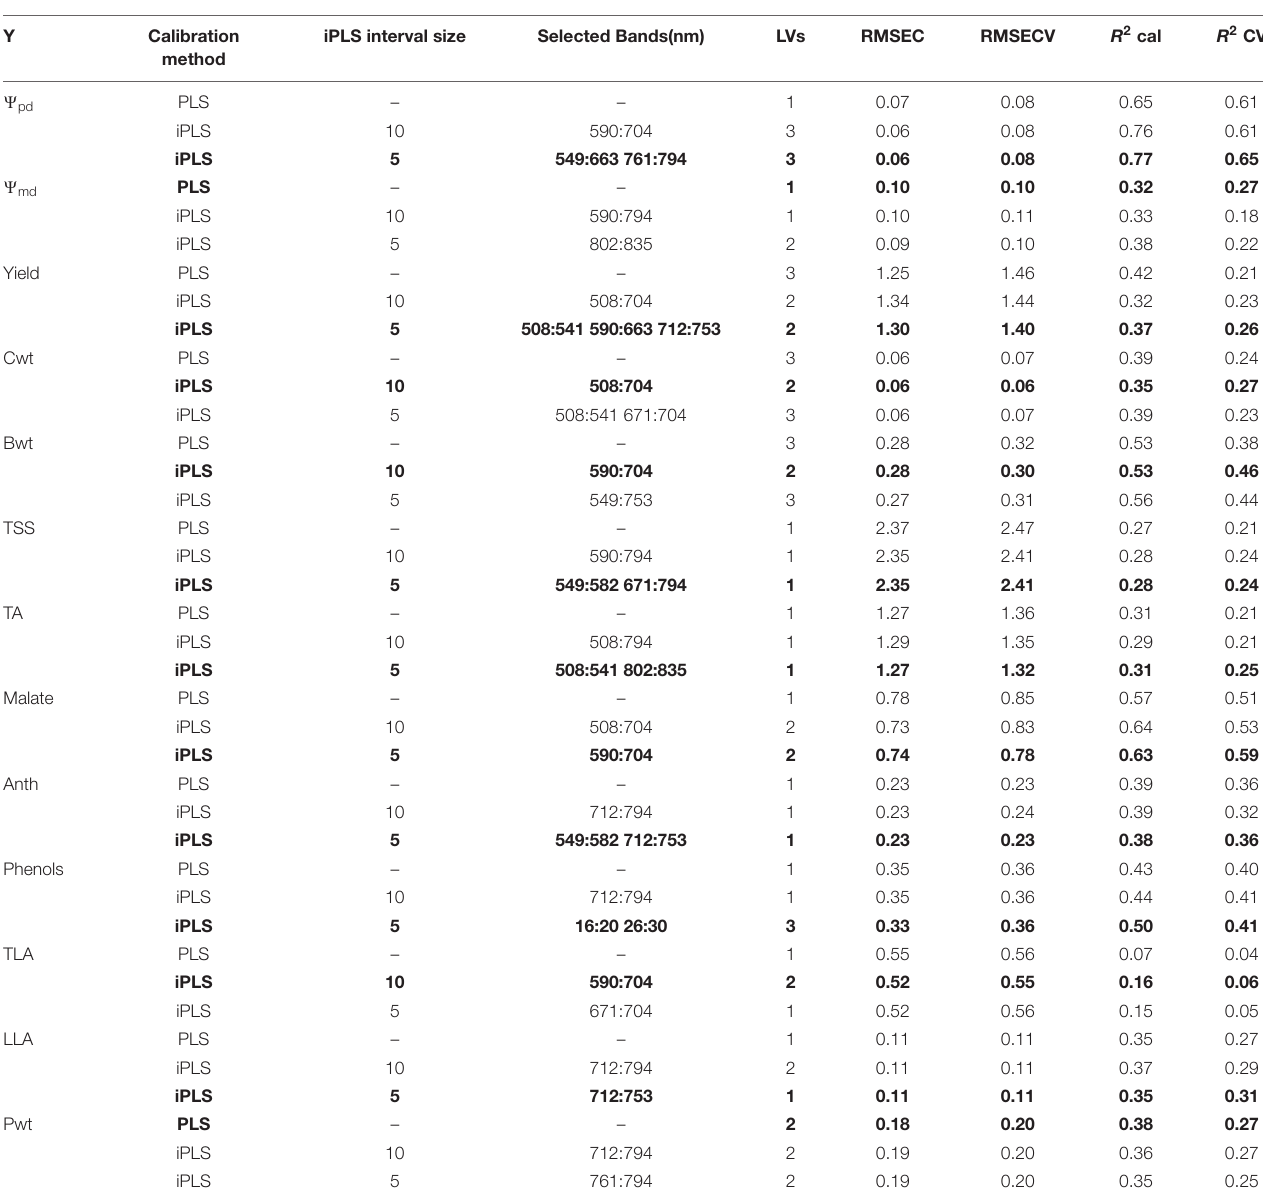
TABLE 4 | Results of PLS and iPLS